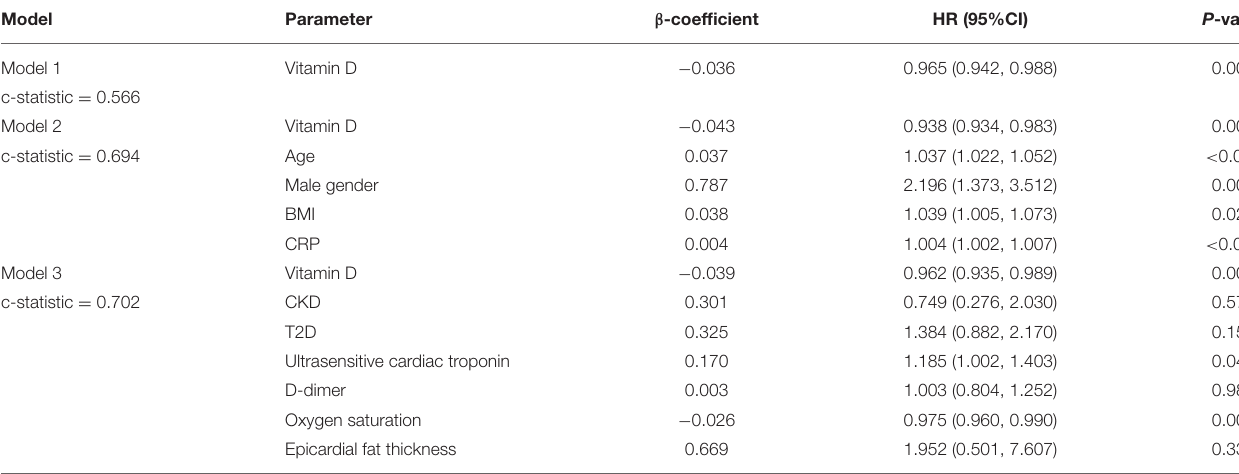
TABLE 3 | Cox proportional risk regression models to predict mortality related to COVID-19 using Vitamin D levels adjusted for covariates. Model